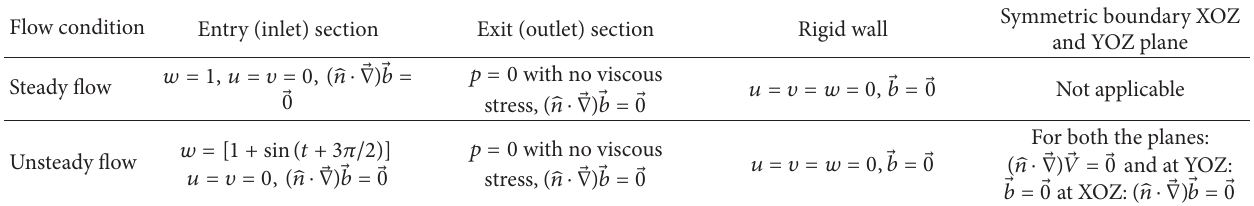
Table 1: Boundary conditions at a